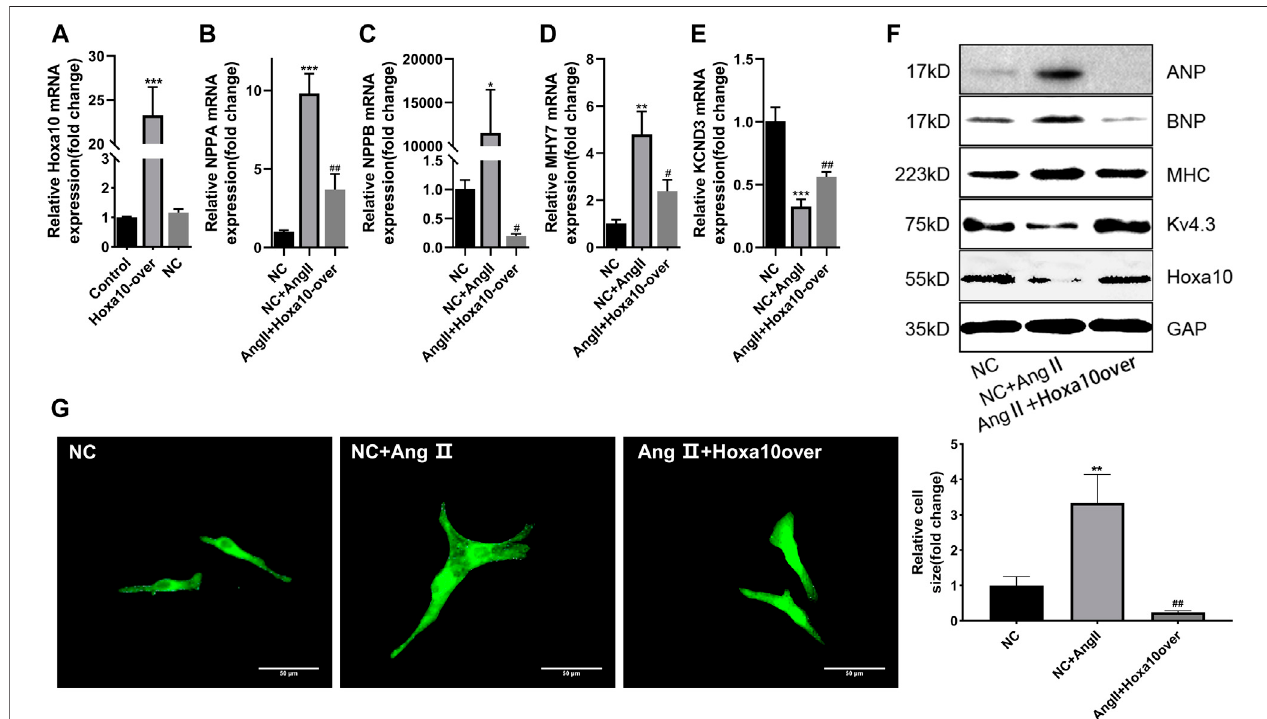
FIGURE6| Hoxa10reversestheprocessofmyocardialhypertrophyandKv4.3reductioninducedbyAngII. (A) TheexpressionofHoxa10inHoxa10-overexpress group was signi fi cantly increased compared with the NC group. (B – D) The expression of cardiac hypertrophy related genes NPPA, NPPB, and MHY7 in NC + Ang II group was signi fi cantly up-regulated compared with the NC group, while down-regulated after treatment with Hoxa10 overexpression. (E) The expression of KCND3 in NC + Ang II group was signi fi cantly down-regulated compared with the NC group, while up-regulated after Hoxa10 overexpression treatment. (F) The protein expressions of ANP, BNP, β -MHC, and Kv4.3 showed similar tendencies as PCR results. The protein expression of Hoxa10 was down-regulated in NC + Ang II group, while up-regulated in Hoxa10-overexpress treatment group (G) Morphological changes after the overexpression of Hoxa10 showed that the area of cardiomyocytes in Ang II + Hoxa10-overexpress group was signi fi cantly smaller than that in NC + Ang II group. Scale bar, 50 μ m. All the values are the mean of three independent experiments ( n (cid:2) 3). *** p < 0.001, ** p < 0.01, * p < 0.05 vs. NC, ### p < 0.001, ## p < 0.01, # p < 0.05 vs. NC + Ang II.